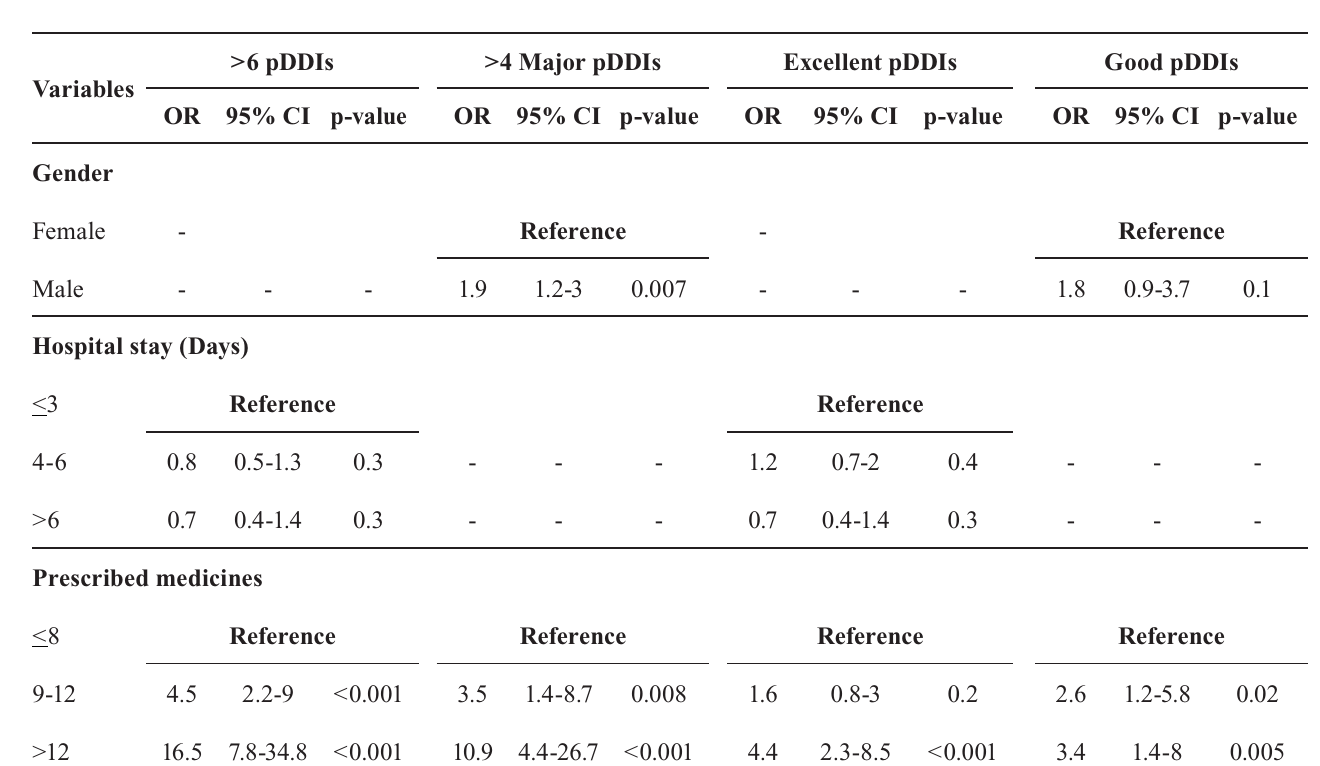
TABLE IV - Multivariate logistic regression analysis based on exposure to >6 pDDIs and >4